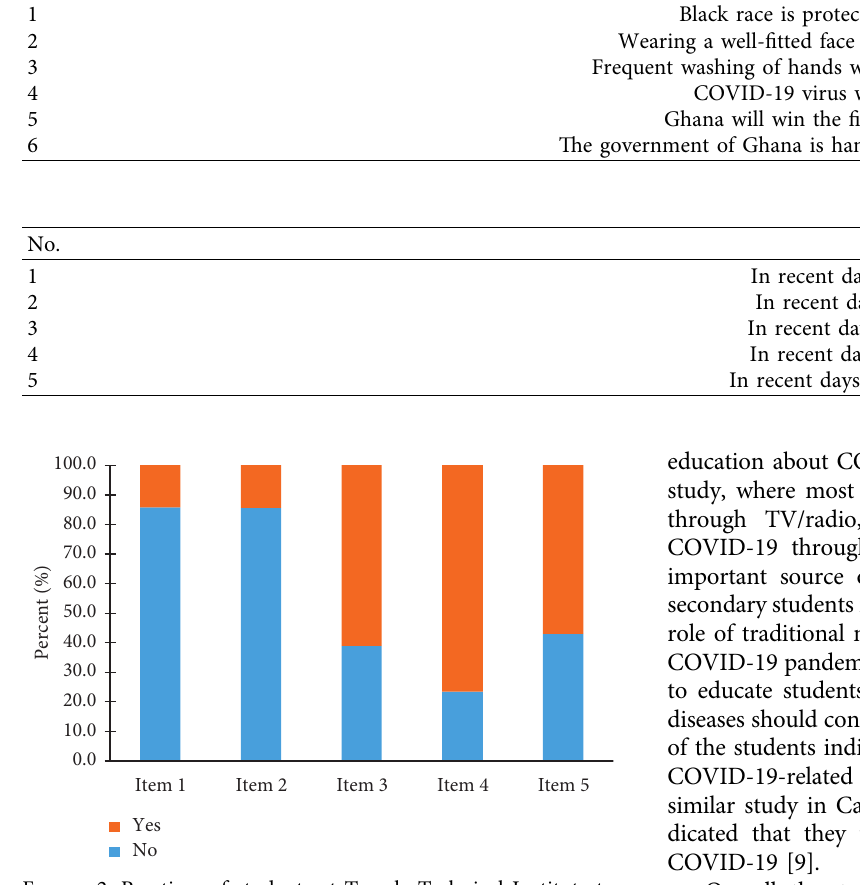
Figure 2: Practices of students at Tamale Technical Institute to- wards